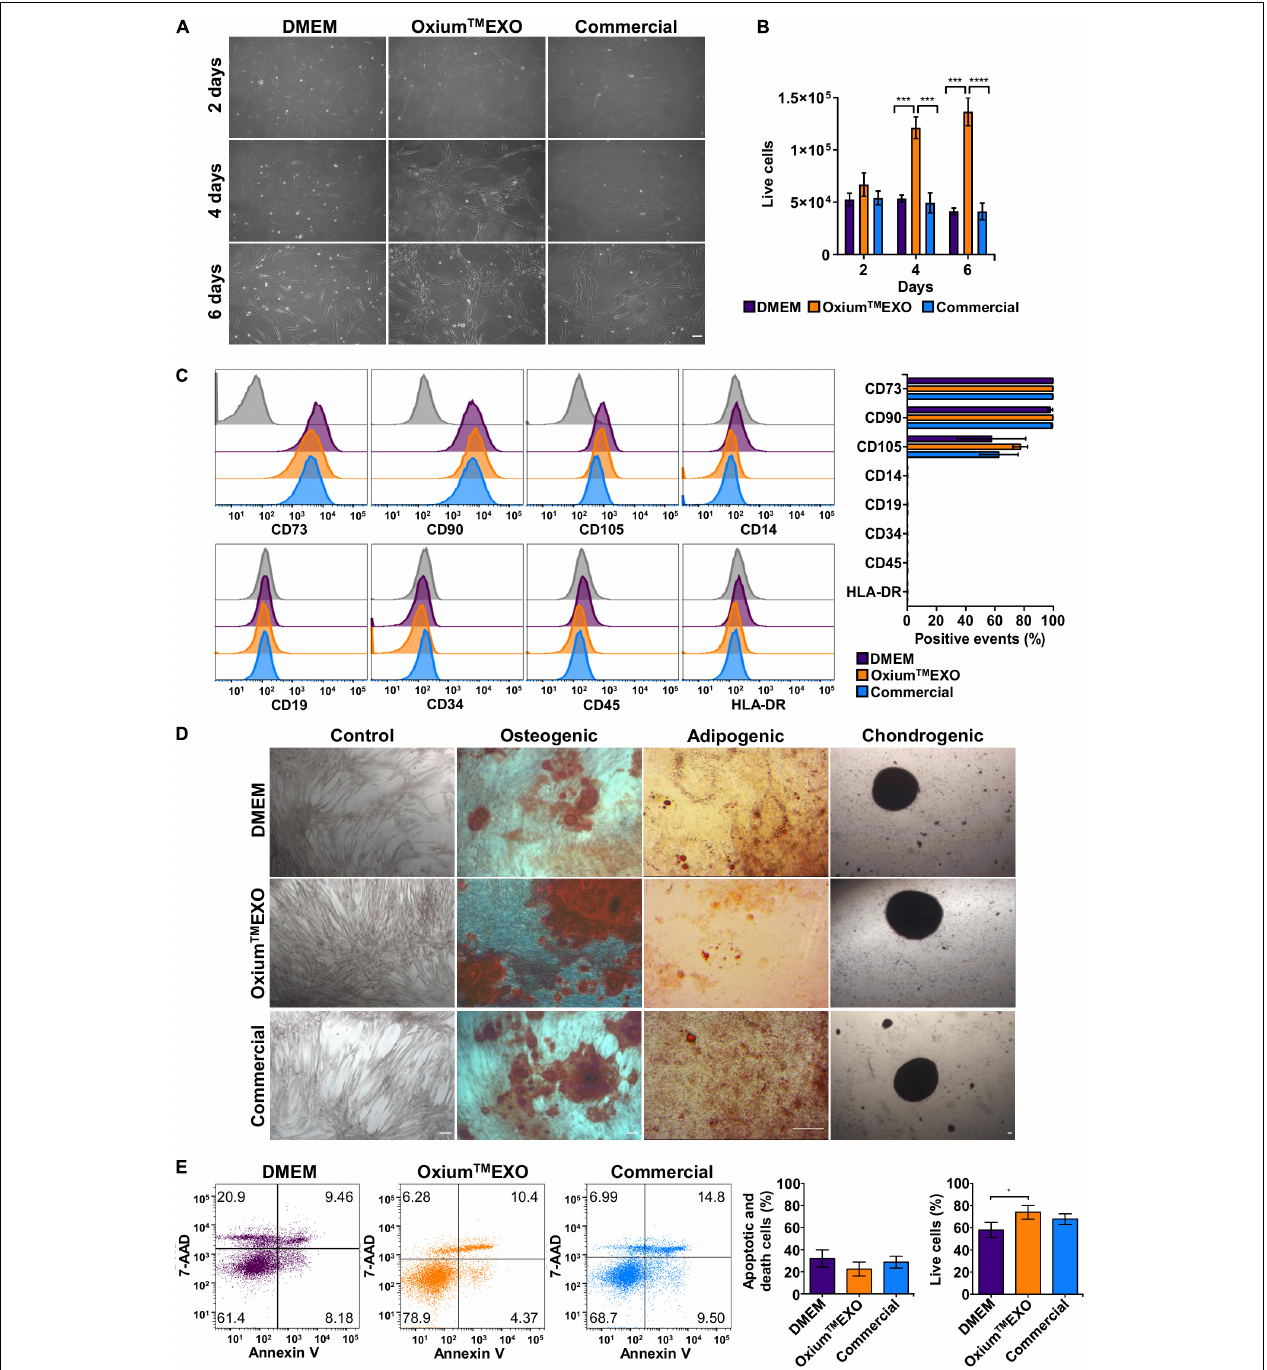
FIGURE 1 | Characterization of UC-MSCs cultured in DMEM, Oxium TM EXO, and commercial medium for sEV production. Umbilical cord-derived mesenchymal stromal cells (UC-MSCs) were evaluated at 2, 4, or 6 days post-induction of sEV secretion with DMEM, Oxium TM EXO, and commercial medium. (A) Microscope images showing cell morphology at the different days post-induction, acquired with an Olympus CKX41 microscope using 10 × magnification (scale bar 100 µ m). (B) After 2, 4, and 6 days post-induction, live cells were counted with the Neubauer chamber. ** P < 0.01, **** P < 0.0001, two-way ANOVA, followed by Tukey’s comparison test. (C) Flow cytometry analysis of MSCs’ classical surface and purity-control antigens at 6 days post-induction. Histograms of fluorescence intensity for each marker assayed are shown; gray histograms correspond to unstained cell control for each marker. Quantification of positive events for each marker is shown in terms of percentage of total events. (D) Multilineage differentiation capacity of UC-MSCs previously cultured for 6 days in the different induction media. Representative images are shown. (E) Detection of apoptosis and cell death according to Annexin V/7-AAD staining and its quantification 6 days post-induction. A representative dot plot is shown for each condition. The graphs show mean ± SEM, n = 6. * P < 0.05, One tailed t-student.